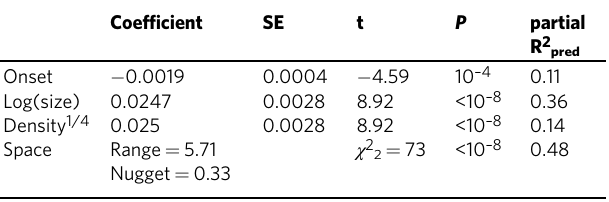
Table 1 Factors explaining the initial spread rate of COVID- 19 for 160 county and county-aggregates in the